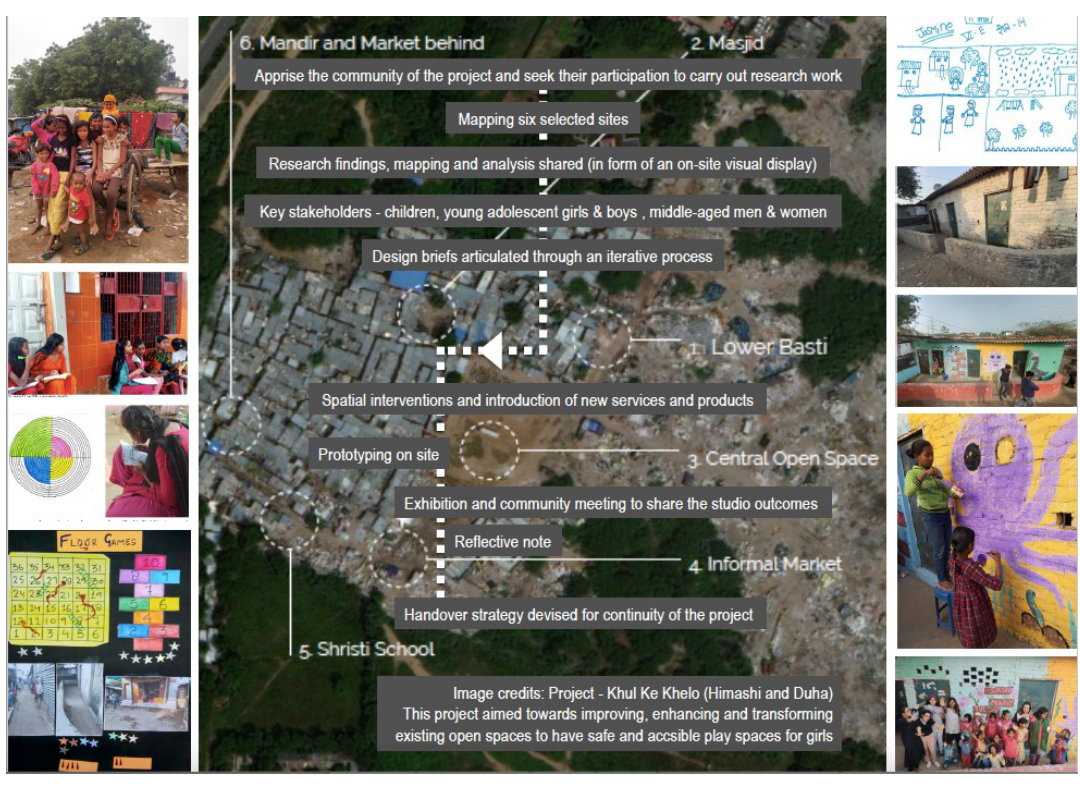
Figure 1. Project development phases of the social design studio (Source: photo composition by Divya